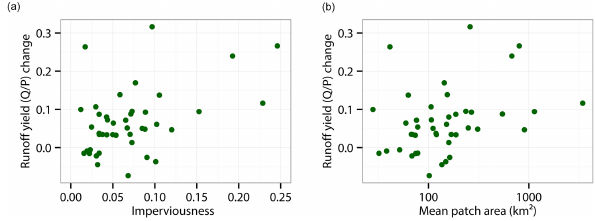
Figure 4. Residual runoff yield change versus the proportion of catchment area with more than 50% imperviousness (left) and ver- sus the mean patch area of catchment with more than 20% imper- viousness